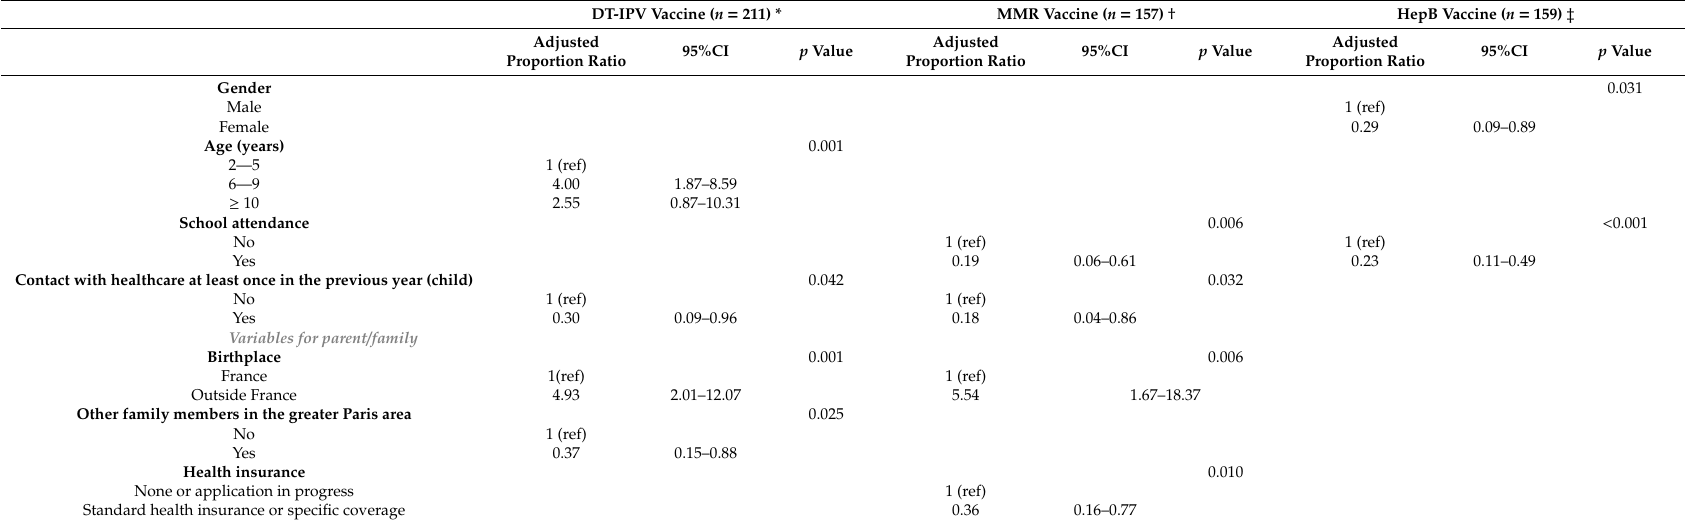
Table 3. Factors associated with insu ffi ciently immunized children for DT-IPV, MMR and HepB based on a multivariate robust Poisson model among children born in